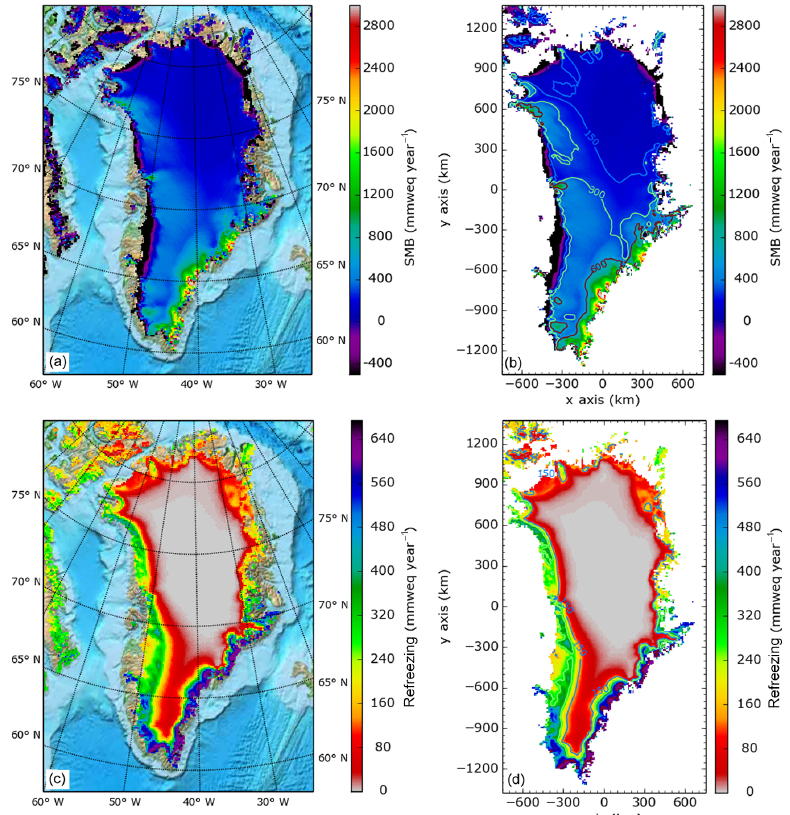
Figure 8. Panels (a, c) respectively show the surface mass balance (SMB) and the refreezing of the 1958–1989 time average of the RACMO2.3 data set for Greenland on a reduced Gaussian grid with an horizontal resolution of about 11 km; the coloured ETOPO back- ground replaces the masked area. In (b, d) the SMB and the refreezing have been masked mapped on a 5km × 5km ISM grid with an optimal projection. Both fields are expressed in millimetre water equivalent (mmweqyear − 1